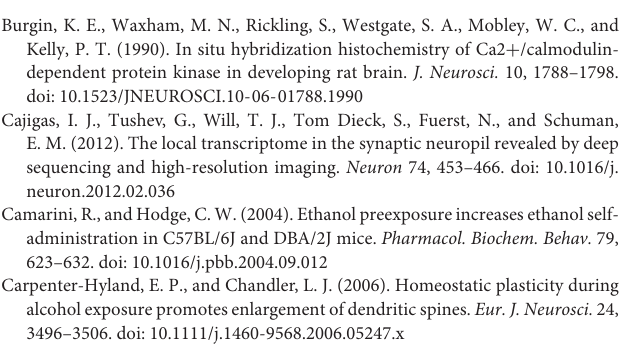
TABLE S12 | Synapse-specific differential exon usage. TABLE S13 | MEME motif count